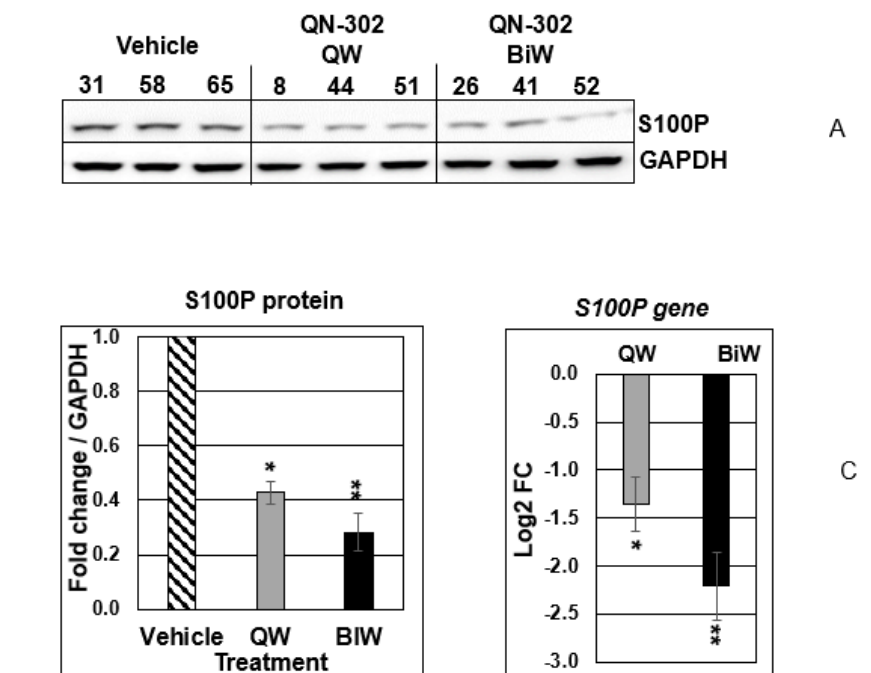
Figure 2. ( A ) Western blots of S100P protein and GAPDH control, for protein extracted from the results of the xenograft experiment with MIA PaCa-2 implanted tumors and a vehicle control arm, at day 28 of the study. The number at the top of each individual column represents an individual mouse. QW: once-weekly dosing. BiW: twice-weekly dosing. ( B ) Quantitation of the Western blot data. Statistical significances are indicated by * p < 0.05, ** p < 0.01. ( C ) Quantitation of the qPCR data for the S100P gene in the treated vs. vehicle control animals. Statistical significances are indicated by * p < 0.05, ** p < 0.01 (one-way ANOVA test).